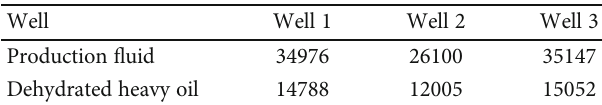
Table 1: Viscosity at 20 ° C of produced fl uids and dehydrated